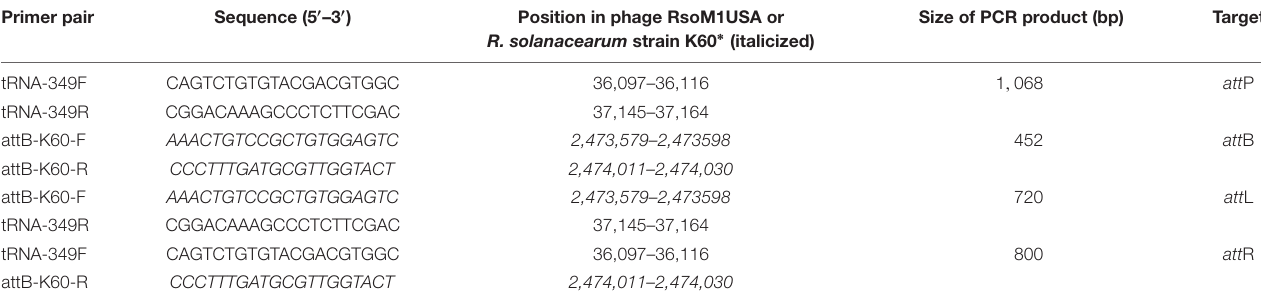
TABLE 3 | List of primer pairs designed and used in this study. Primer pair Sequence (5 (cid:48) –3 (cid:48) ) Size of PCR product